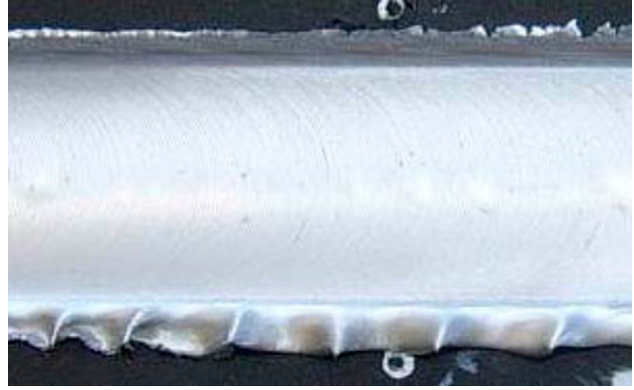
Figure 10. Surface of the joint which verified the best results in mechanical terms (n = 500 rpm; v = 20 cm/min).